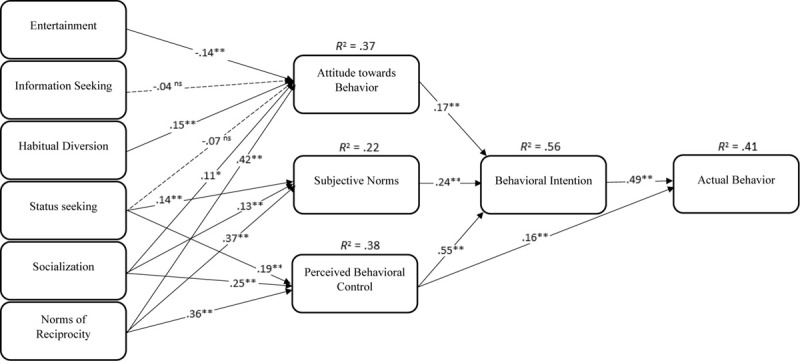
Structural model.